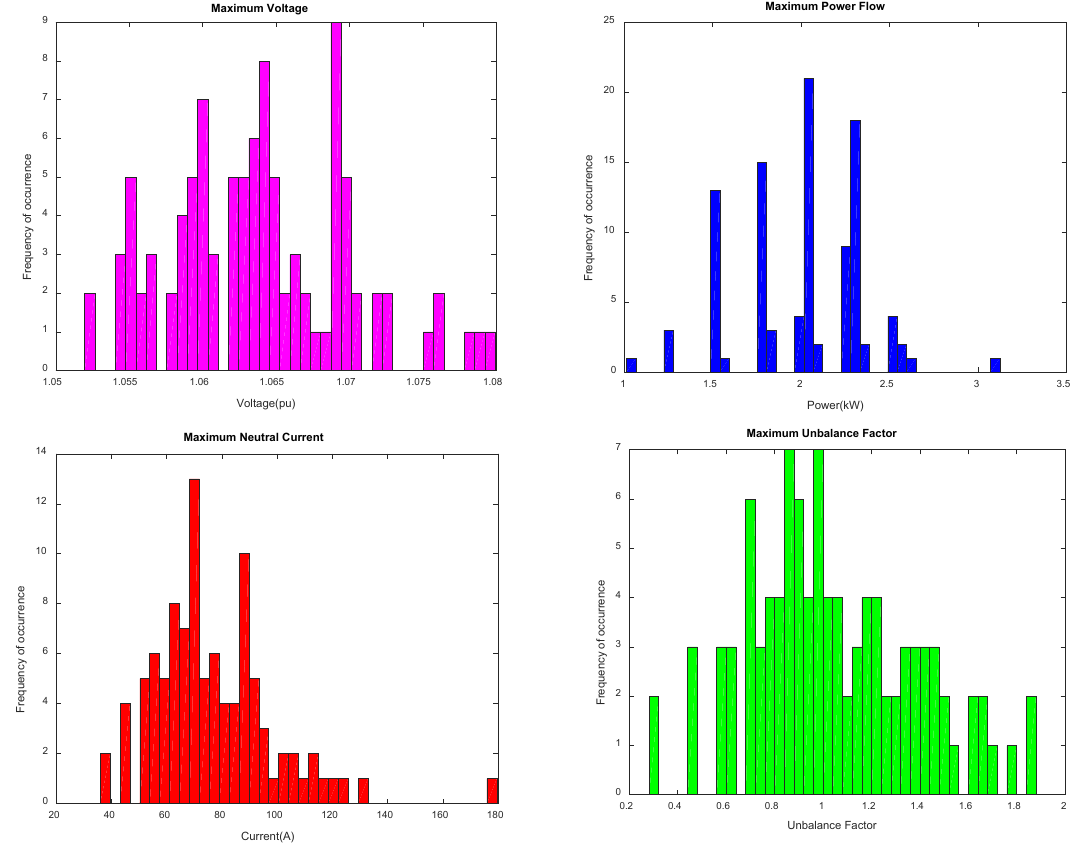
Figure 8: Distribution of extracted parameters (Case